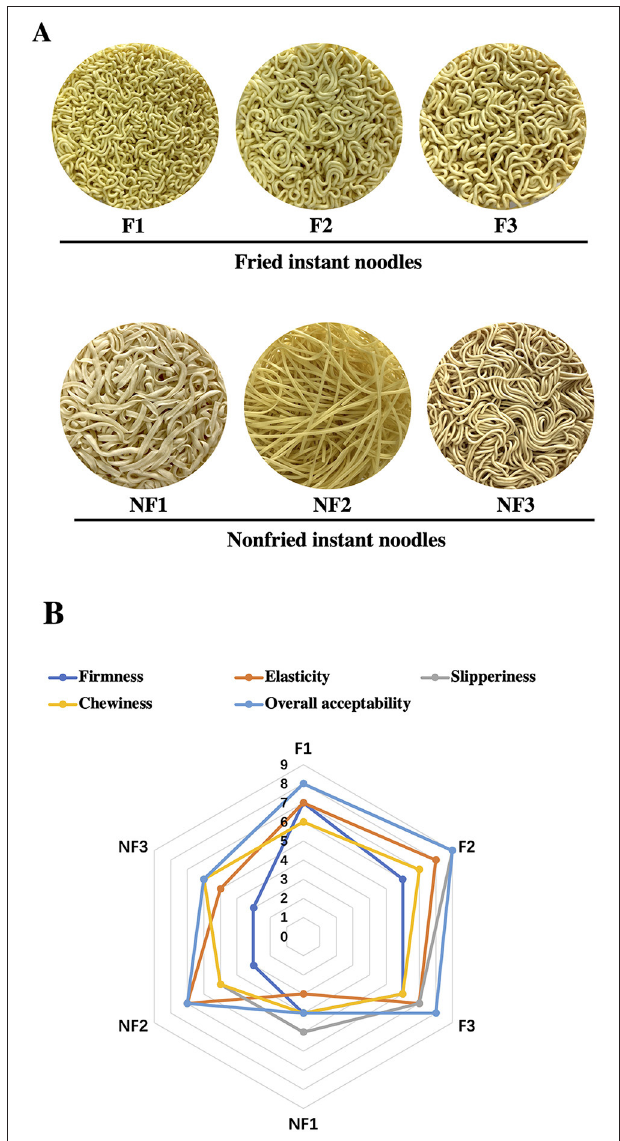
groups per gram of completely hydrolyzed protein (8.83 mmol/g protein). X is the weight of the sample tested; P is the protein content of the sample tested; and α and β are expressed by the constants 1.00 and 0.40,